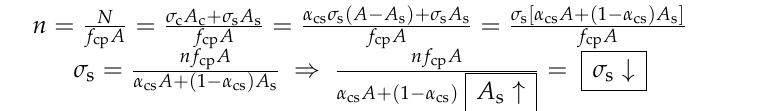
( b ) ( c ) Figure 15. Effect of bi-directional loading on hysteresis loops of RRC columns ( n = 0.3). ( a ) r = 0%, ( b ) r = 50%, and ( c ) r = 100%. -80